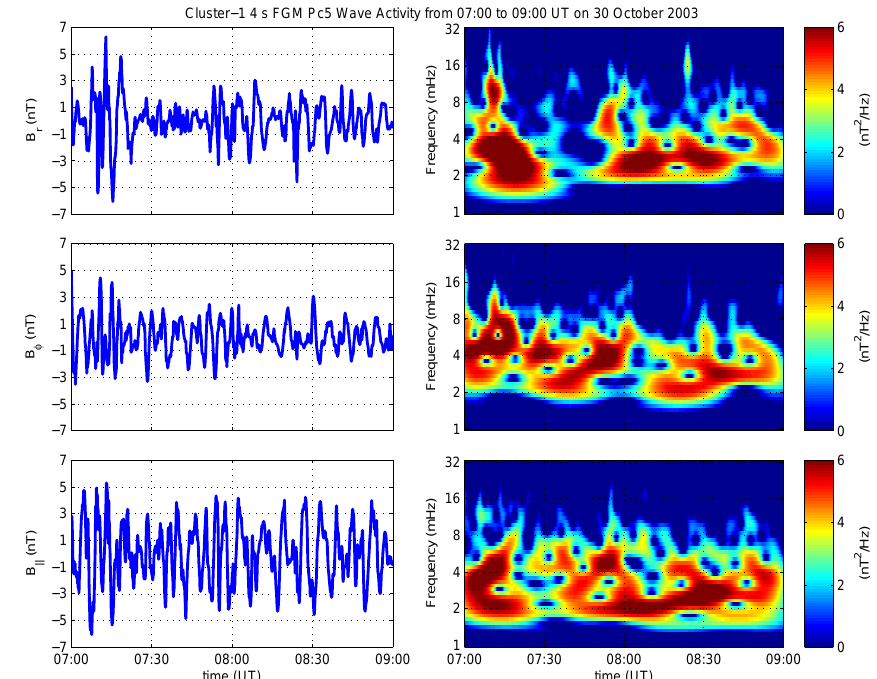
Fig. 8. Event 1: 07:00–09:00UT, 30 October 2003. The Cluster-1 Pc5 (1–32mHz) activity. Left column: From top to bottom are shown the time series of the poloidal, toroidal and compressional components, respectively, of the magnetic field, calculating from the 4s FGM data after applying a 2mHz high-pass filter. Right column: From top to bottom are shown the corresponding wavelet power spectra.